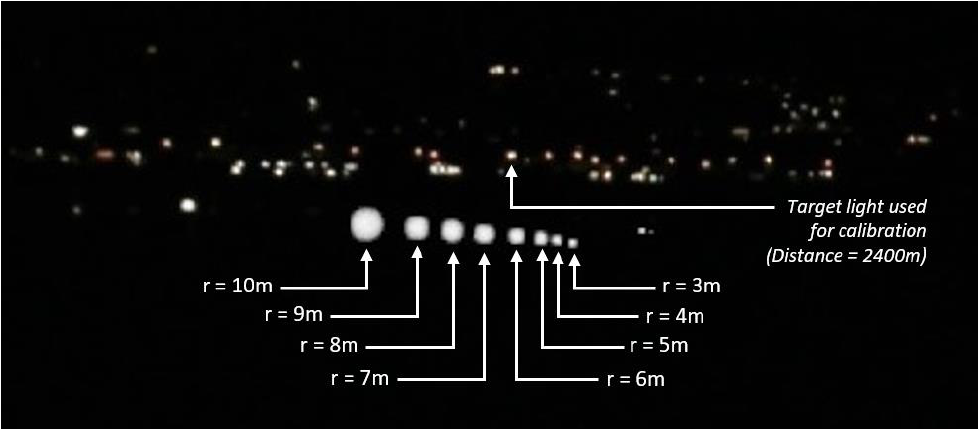
Figure 6. Comparison of light and sphere at a distance over water of 2400 m in Newnham Tasmania.